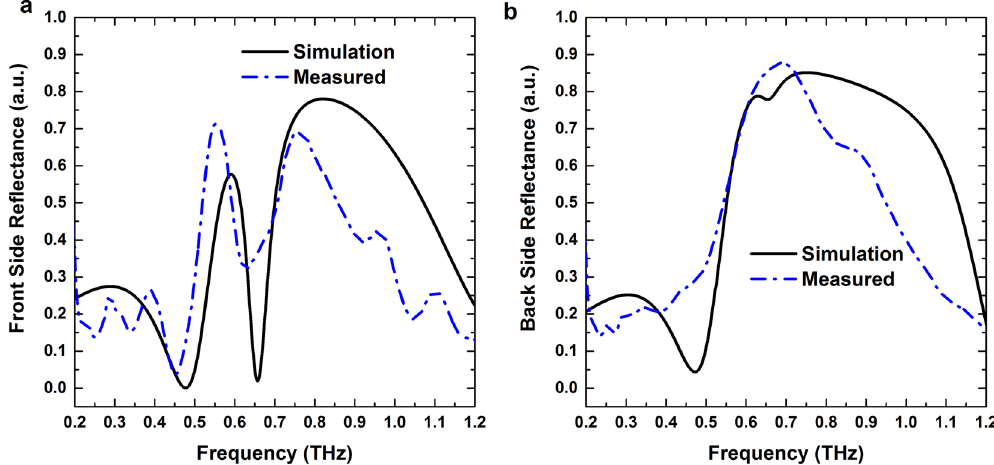
Figure 3. Simulated and measured reflection spectra for ( a ) Front side and ( b ) Back side